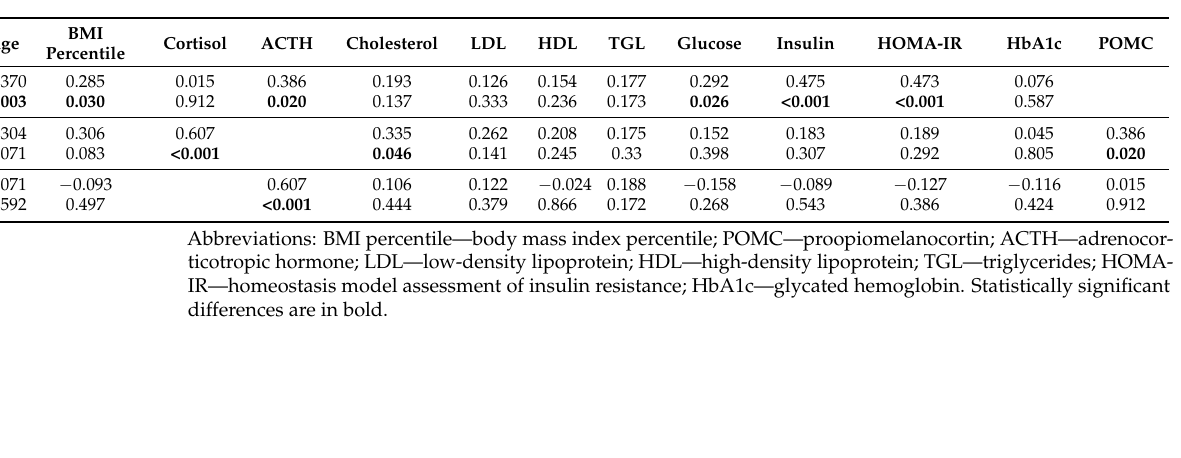
Table 4. Spearman rank correlation coefficients (R) and p -values between hormone concentrations and clinical features of the patients studied.